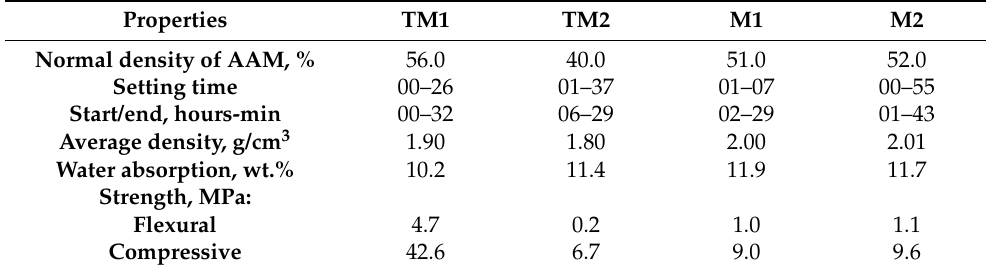
Table 4. Fresh, physical, and mechanical properties of